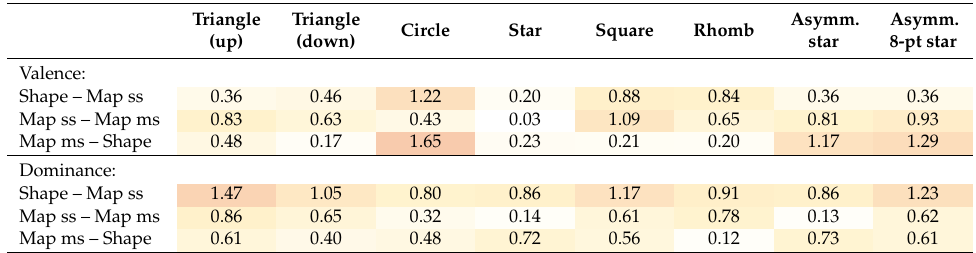
Asymm. Asymm. star 8-pt